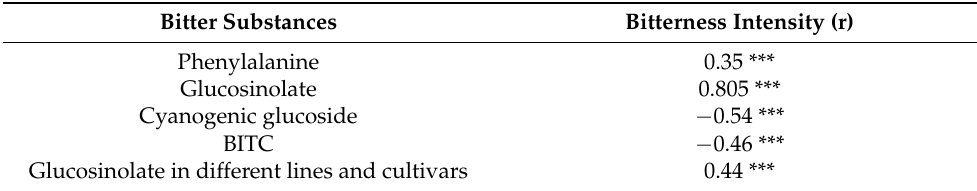
Table 1. Correlation of bitterness intensity with phenylalanine, cyanogenic glucoside, glucosinolate, and BITC. Bitter Substances Bitterness Intensity (r) Phenylalanine 0.35 *** Glucosinolate 0.805 *** Cyanogenic glucoside − 0.54 *** BITC − 0.46 *** Glucosinolate in different lines and cultivars 0.44 *** (***: p <